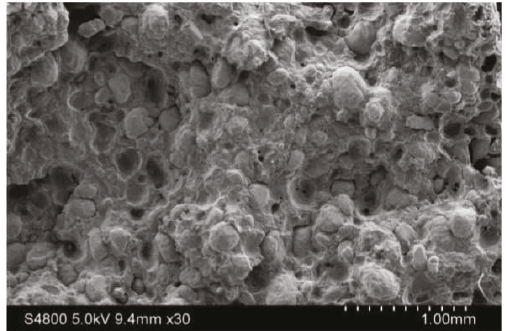
Figure 1: SEM image of the HTPB